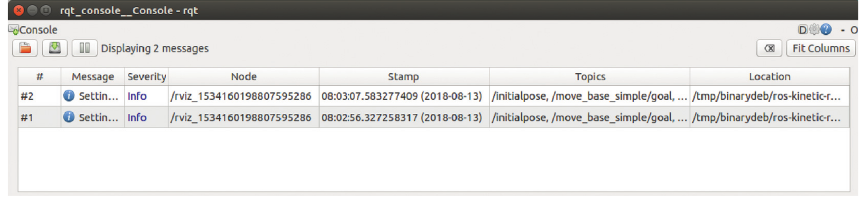
Figure 8: Response log of the service robot for voice